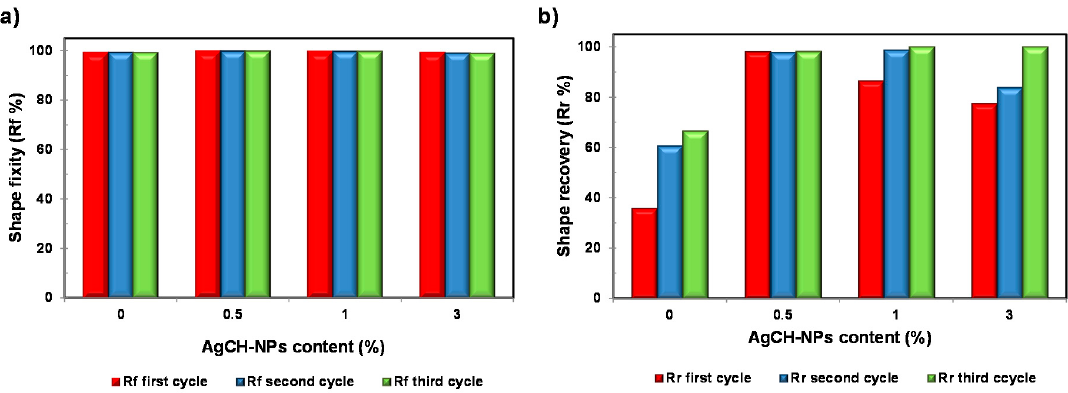
Figure 7. Shape fixity ratio ( a ) and shape recovery ratio ( b ) characteristic values for neat PLA / OLA and its nanocomposites containing 0.5, 1 and 3 wt.% of AgCH-NPs.